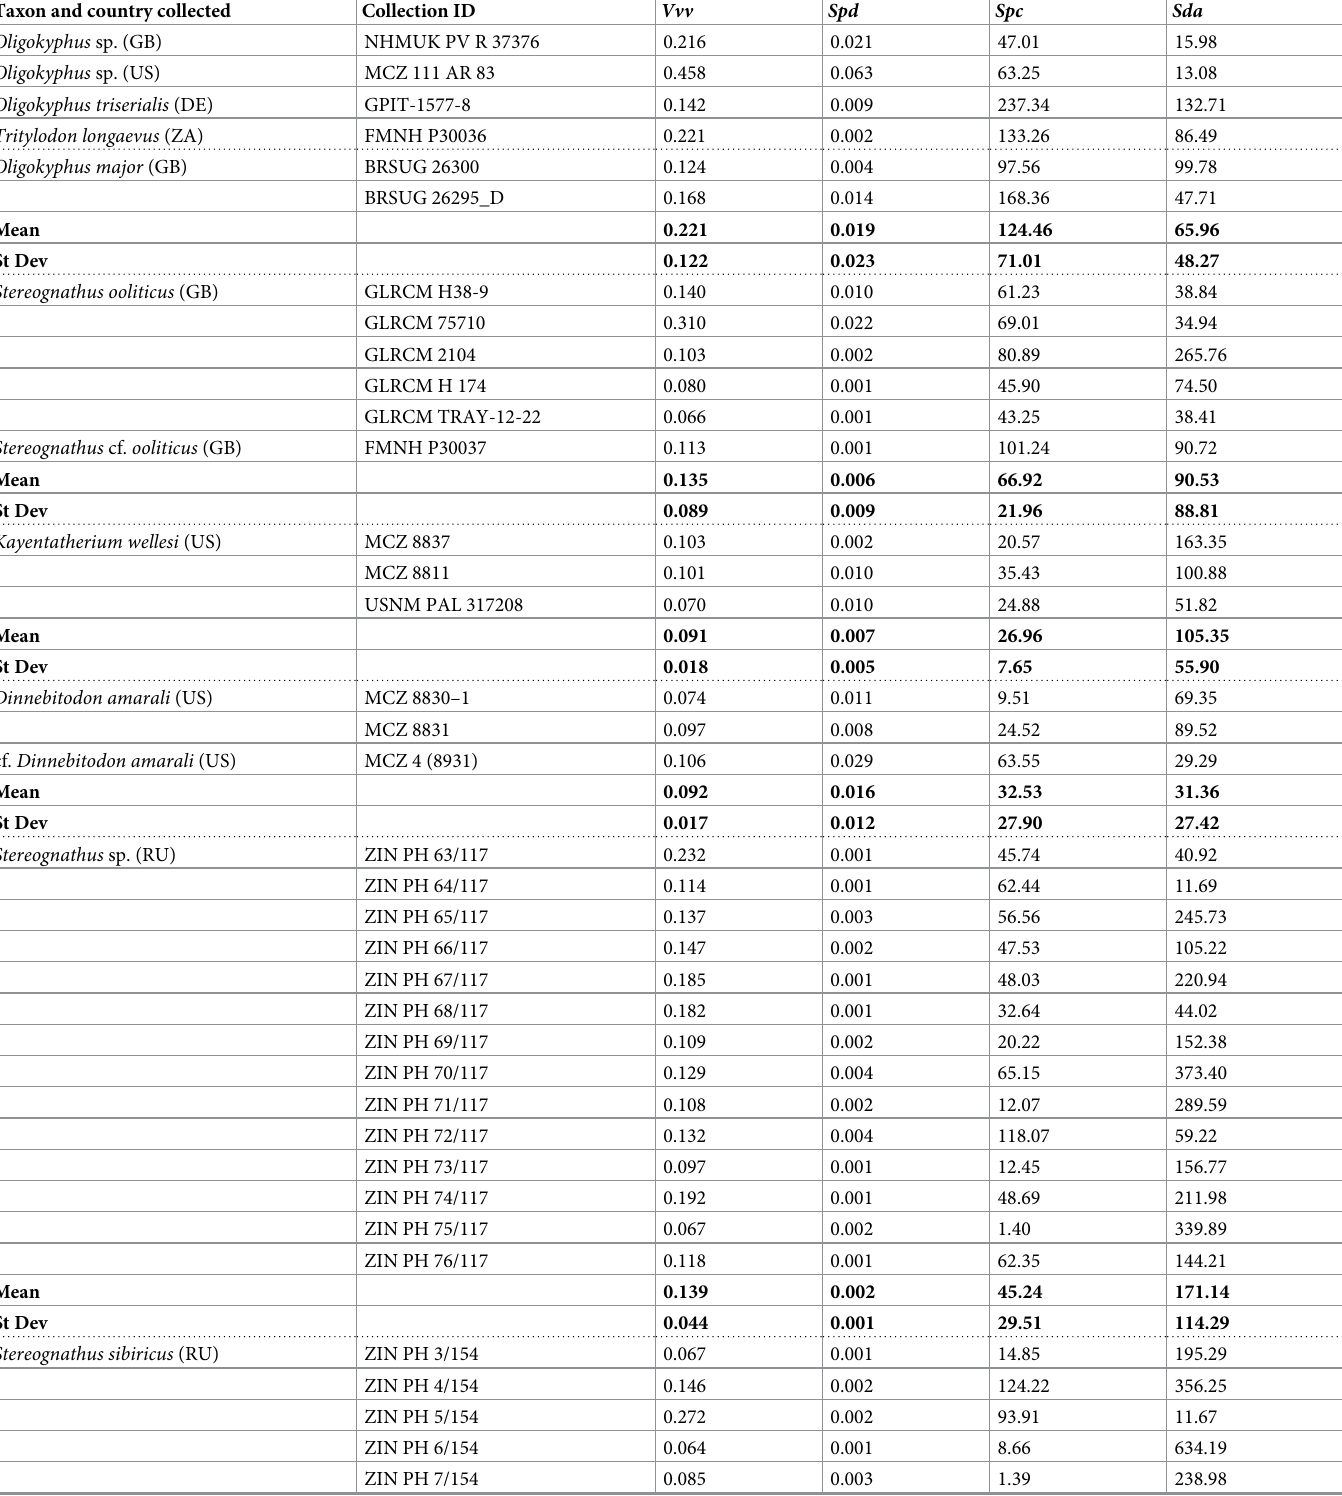
Table 4. Surface texture parameters for all individuals. Taxon and country